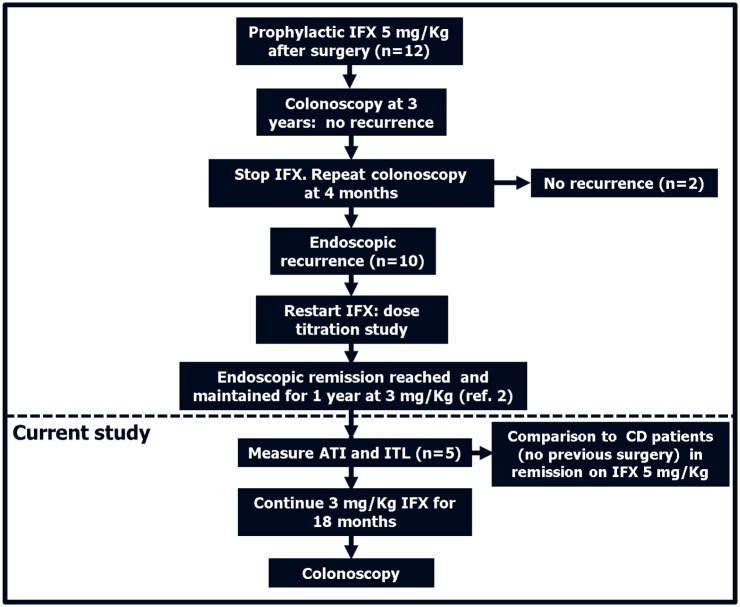
Study Design.Patients subjected to prophylactic infliximab [IFX] 5 mg/Kg after surgery and in full remission after 3 years of therapy showed endoscopic recurrence in 83% of cases when the medication was stopped. Those with recurrence (n = 10) re-started IFX in a dose optimization study in which we showed that 3 mg/Kg were sufficient to re-induce and maintain endoscopic remission for 1 year in all patients (ref.2). Five of these ten patients participated in the current study. Antibodies To Infliximab [ATI] and Infliximab Trough Levels [ITL] were measured and compared to those of CD patients who did not undergo surgery in remission on a standard 5 mg/Kg IFX dose. After an additional 18 months the patients treated with 3 mg/Kg IFX underwent colonoscopy.